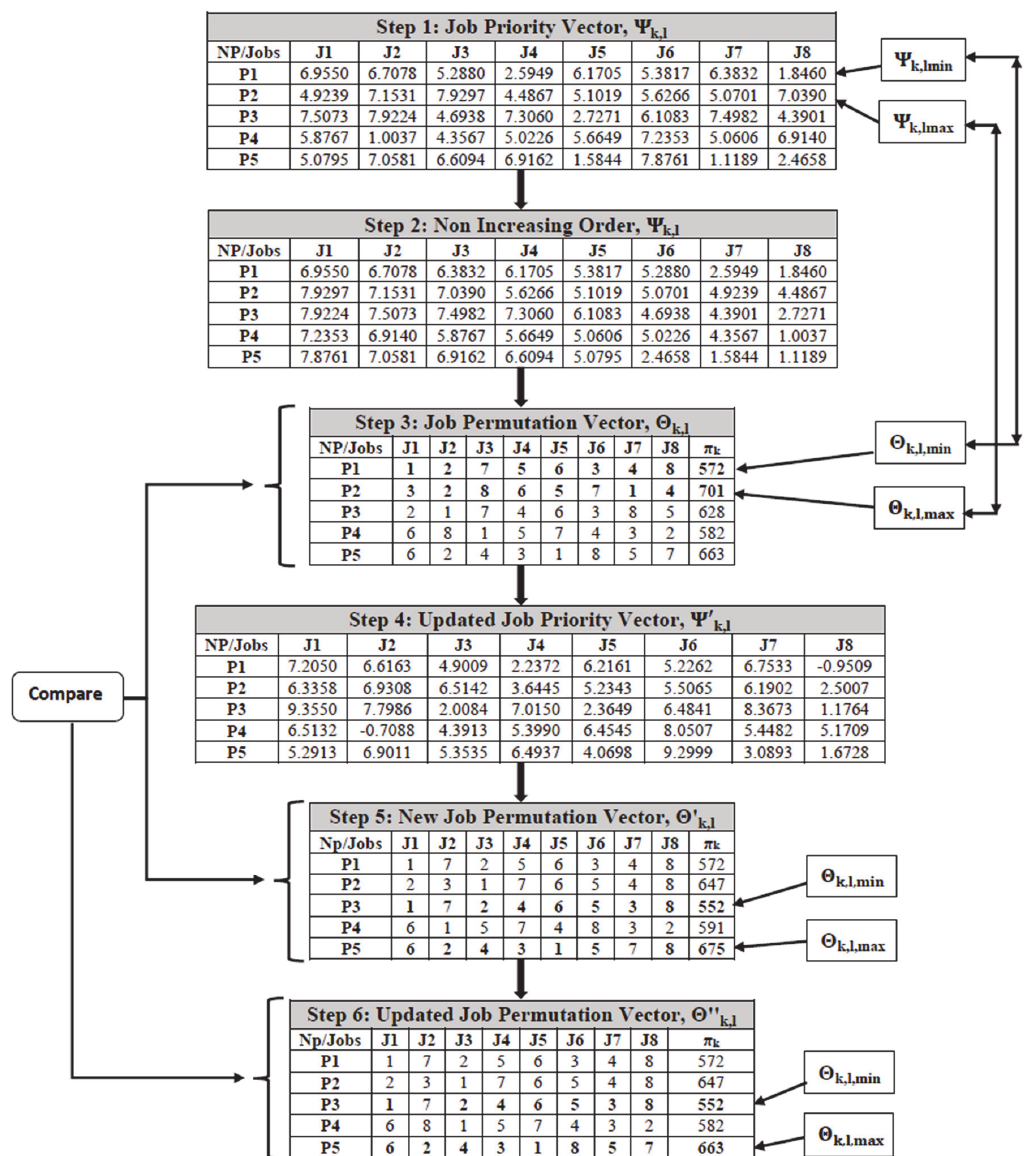
Fig. 2. An example to demonstrate the application of Jaya algorithm for